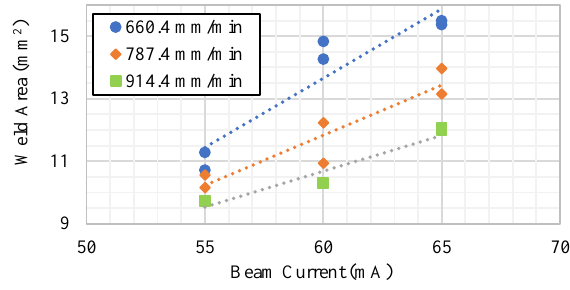
Figure 10: Variation in weld area with beam current at various welding speeds